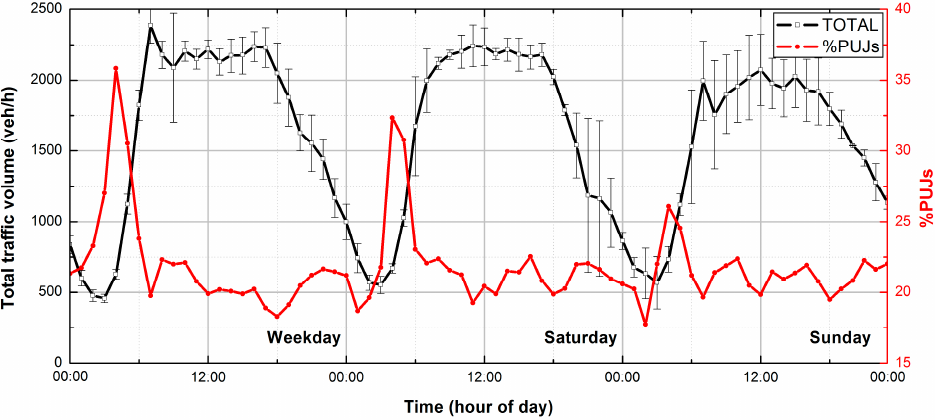
Figure 3. Diurnal variation of the total traffic volume and the fraction of public utility jeepneys (PUJs) at Taft Avenue on weekdays and weekends. Error bars show standard deviation.